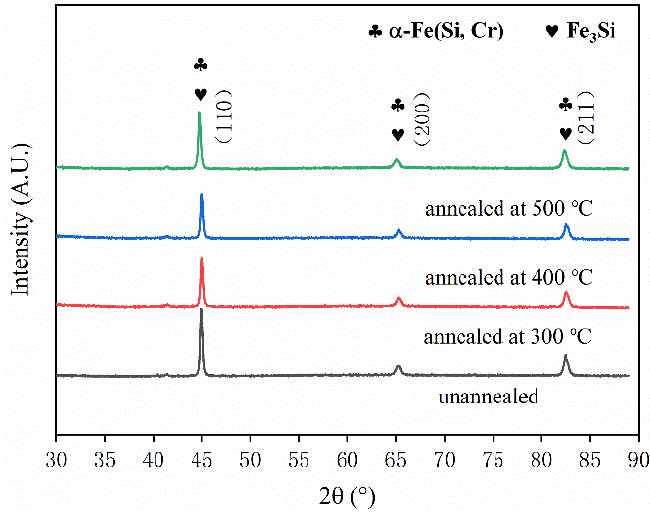
Figure 11. XRD patterns of Fe-Si-Cr SMCs at different annealing temperatures.